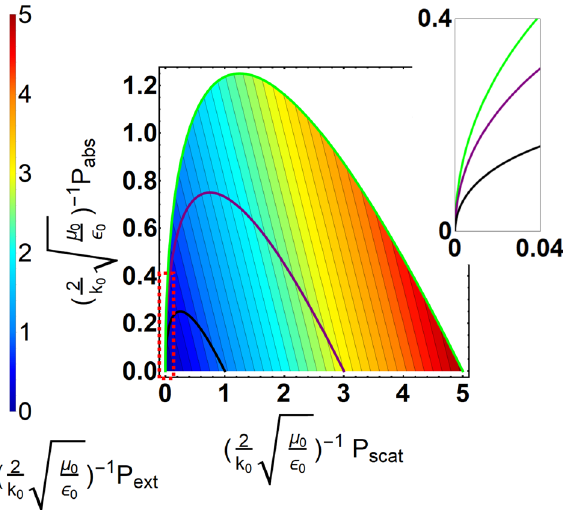
Figure 1. Power contour diagram for normalized absorption, scattering, and extinction powers. The black line indicates the boundary for a system with N = 0 mode dominant, the purple is for n = [− 1, 0, 1 ] modes, and the green is for n = [− 2, − 1, 0, 1, 2 ] modes. The red dashed box highlights a region with a lower scattering, but with overwhelming absorption. Inset shows the detailed power distribution among absorption and scattering for the corresponding red dashed